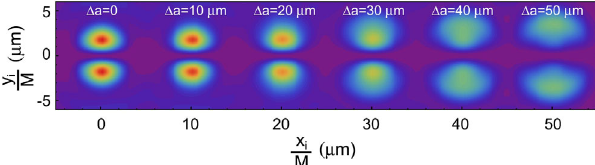
FIG. 4. SPFs calculated for horizontally displaced radiation emitters from a tilted target surface, emulating OTR emission from individual electrons out of a σ x ¼ 30 μ m thick beam profile. The numerical aperture amounts to θ m ¼ 0 . 10 .